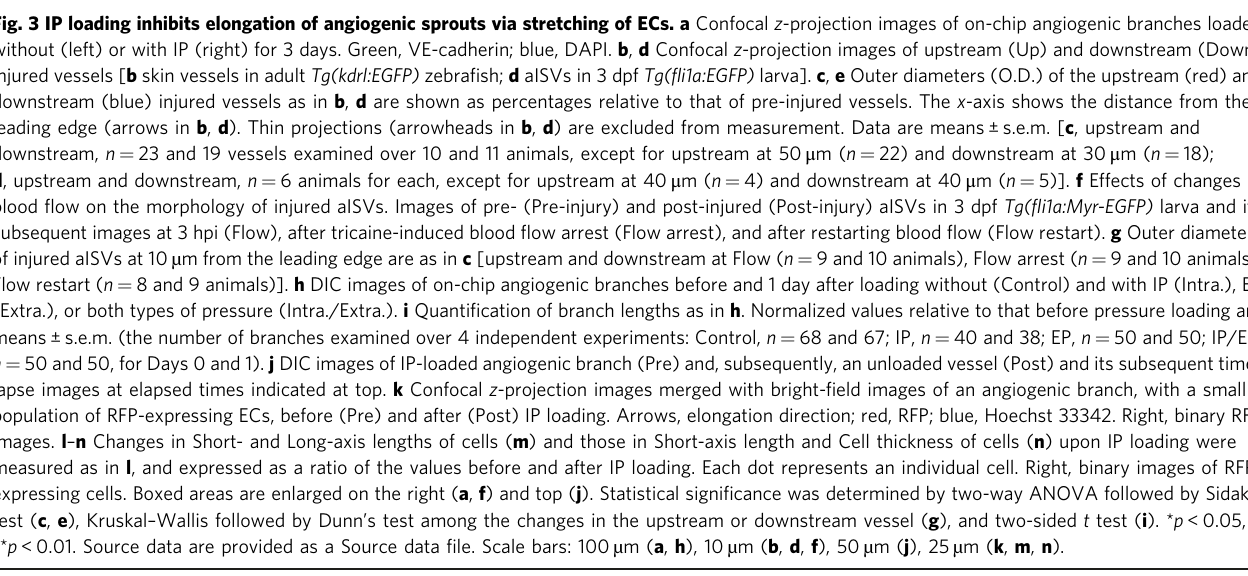
Fig. 3 IP loading inhibits elongation of angiogenic sprouts via stretching of ECs. a Confocal z -projection images of on-chip angiogenic branches loaded without (left) or with IP (right) for 3 days. Green, VE-cadherin; blue, DAPI. b , d Confocal z -projection images of upstream (Up) and downstream (Down) injured vessels [ b skin vessels in adult Tg(kdrl:EGFP) zebra fi sh; d aISVs in 3 dpf Tg( fl i1a:EGFP) larva]. c , e Outer diameters (O.D.) of the upstream (red) and downstream (blue) injured vessels as in b , d are shown as percentages relative to that of pre-injured vessels. The x -axis shows the distance from the leading edge (arrows in b , d ). Thin projections (arrowheads in b , d ) are excluded from measurement. Data are means ± s.e.m. [ c , upstream and downstream, n = 23 and 19 vessels examined over 10 and 11 animals, except for upstream at 50 μ m ( n = 22) and downstream at 30 μ m ( n = 18); d , upstream and downstream, n = 6 animals for each, except for upstream at 40 μ m ( n = 4) and downstream at 40 μ m ( n = 5)]. f Effects of changes in blood fl ow on the morphology of injured aISVs. Images of pre- (Pre-injury) and post-injured (Post-injury) aISVs in 3 dpf Tg( fl i1a:Myr-EGFP) larva and its subsequent images at 3 hpi (Flow), after tricaine-induced blood fl ow arrest (Flow arrest), and after restarting blood fl ow (Flow restart). g Outer diameters of injured aISVs at 10 µ m from the leading edge are as in c [upstream and downstream at Flow ( n = 9 and 10 animals), Flow arrest ( n = 9 and 10 animals), Flow restart ( n = 8 and 9 animals)]. h DIC images of on-chip angiogenic branches before and 1 day after loading without (Control) and with IP (Intra.), EP (Extra.), or both types of pressure (Intra./Extra.). i Quanti fi cation of branch lengths as in h . Normalized values relative to that before pressure loading are means ± s.e.m. (the number of branches examined over 4 independent experiments: Control, n = 68 and 67; IP, n = 40 and 38; EP, n = 50 and 50; IP/EP, n = 50 and 50, for Days 0 and 1). j DIC images of IP-loaded angiogenic branch (Pre) and, subsequently, an unloaded vessel (Post) and its subsequent time- lapse images at elapsed times indicated at top. k Confocal z -projection images merged with bright- fi eld images of an angiogenic branch, with a small population of RFP-expressing ECs, before (Pre) and after (Post) IP loading. Arrows, elongation direction; red, RFP; blue, Hoechst 33342. Right, binary RFP images. l – n Changes in Short- and Long-axis lengths of cells ( m ) and those in Short-axis length and Cell thickness of cells ( n ) upon IP loading were measured as in l , and expressed as a ratio of the values before and after IP loading. Each dot represents an individual cell. Right, binary images of RFP- expressing cells. Boxed areas are enlarged on the right ( a , f ) and top ( j ). Statistical signi fi cance was determined by two-way ANOVA followed by Sidak ’ s test ( c , e ), Kruskal – Wallis followed by Dunn ’ s test among the changes in the upstream or downstream vessel ( g ), and two-sided t test ( i ). * p < 0.05, ** p < 0.01. Source data are provided as a Source data fi le. Scale bars: 100 µ m ( a , h ), 10 µ m ( b , d , f ), 50 µ m ( j ), 25 µ m ( k , m , n